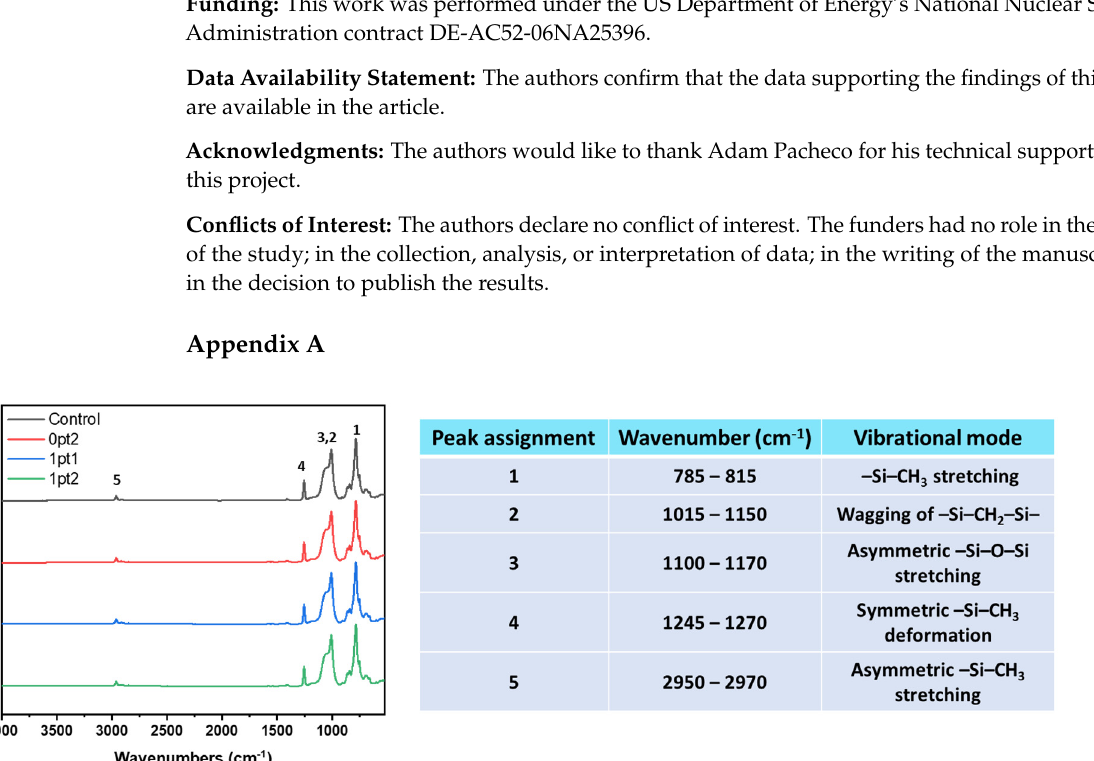
Figure A2. Cumulative molar mass distribution of the extracts from pristine samples.